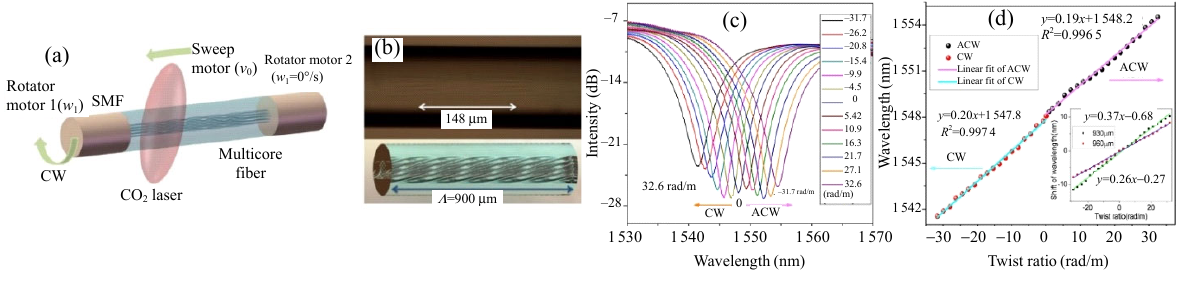
Fig. 8 Schematic diagram and micrograph of the helical LPG based on the MCF and its twist response [76].